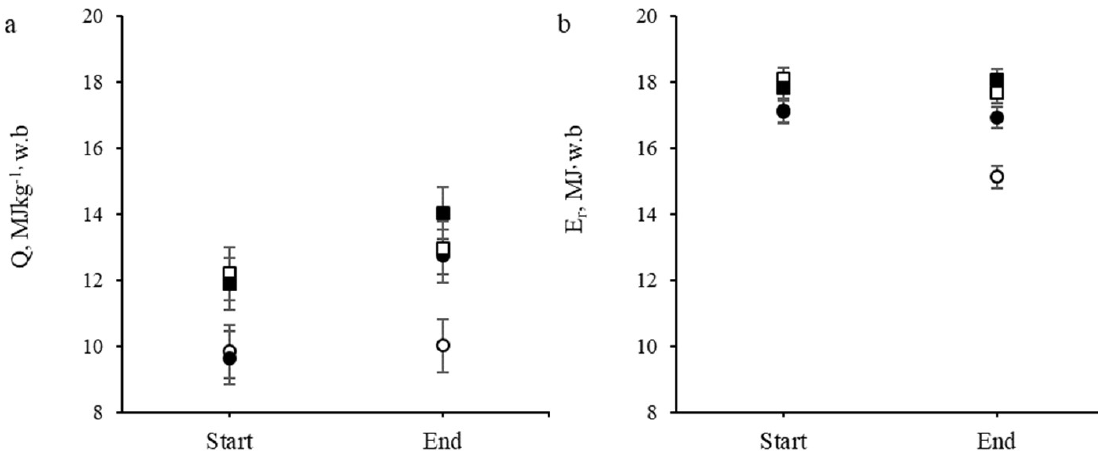
Figure 6. Average values and 95% CI of the net calorific value (Q), expressed on a wet weight basis ( a ) and recovered energy (E r ) per 1 kg dry initial mass expressed on a wet weight basis ( b ) for unsieved and sieved wood chips during storage.